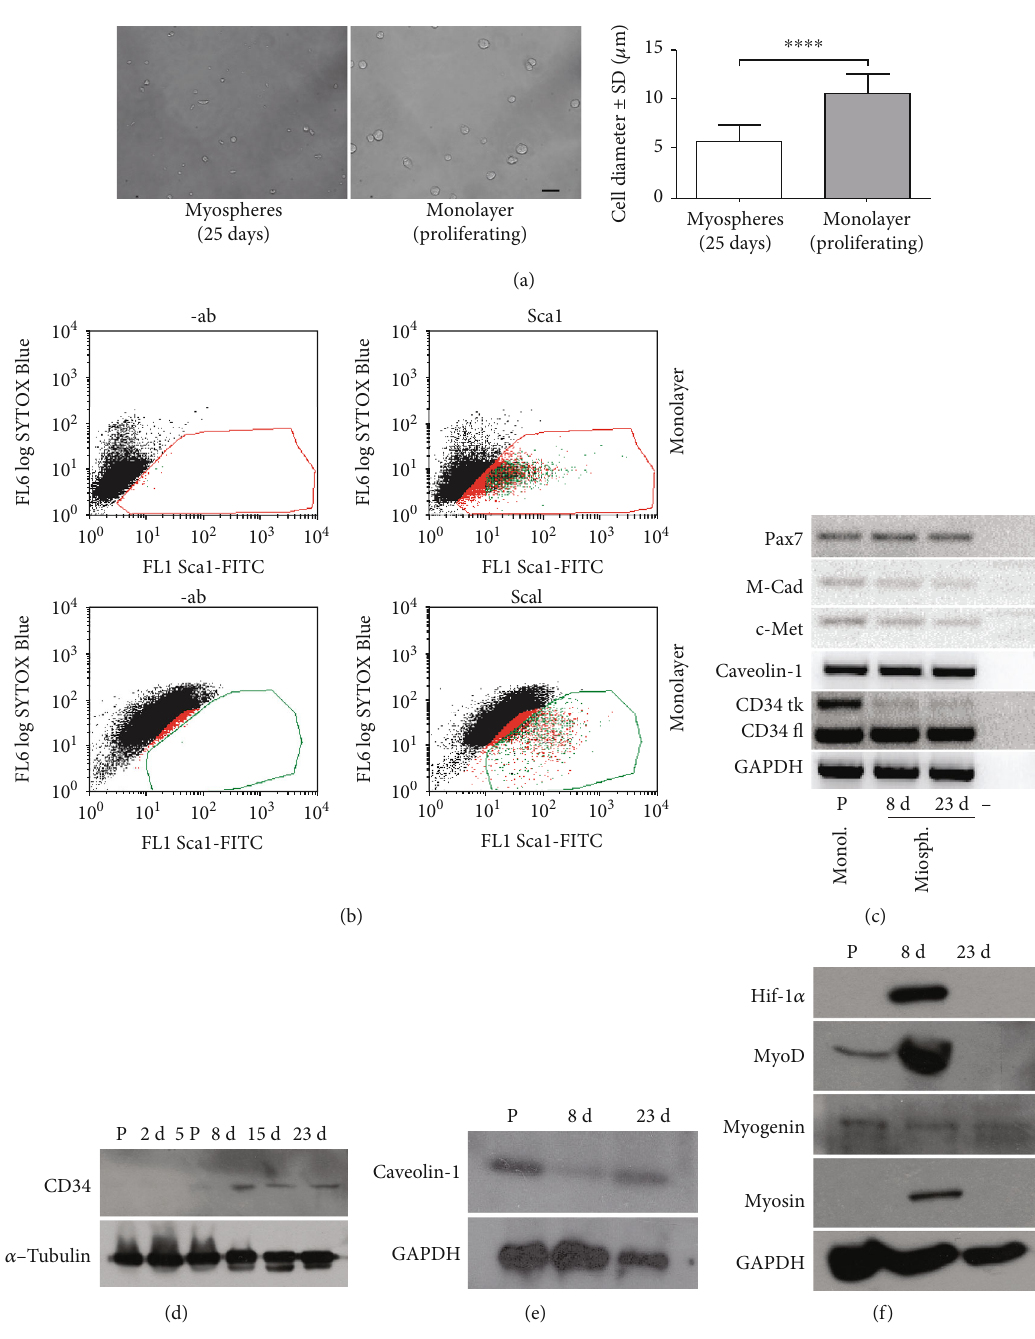
Figure 4: Cell size and marker expression. (a) Representative image comparing C2C12 cells shortly after dissociation of 25-day myospheres and detachment from the monolayer. The graph on the side shows the range of cell diameters. ∗∗∗∗ p < 0 : 0001 . (b) Flow cytometric pro fi le of Sca1 expression in cells from myospheres (25 days) and from a monolayer. (c) Semiquantitative RT-PCR pro fi le of common quiescent satellite cell markers in di ff erentiating and mature myospheres. Myogenin and myosin indicate the presence of di ff erentiating cells. P: proliferating cells in monolayer. (d) Time course of CD34 expression in myospheres by western blot. (e) Caveolin-1 expression in proliferating cells and in di ff erentiating and mature myospheres by western blot. (f) Western blot comparing hif-1 α expression in proliferating cells and myospheres, with the expression of myogenic